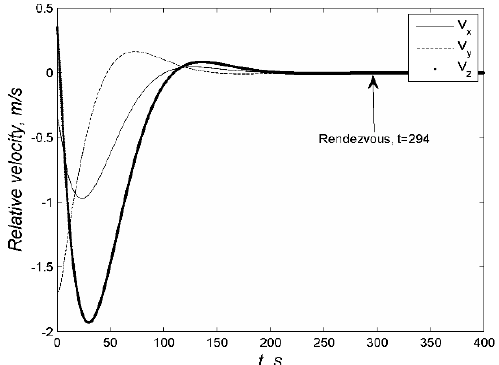
Figure 3. Relative velocity with respect to the target during the capturing maneuver.